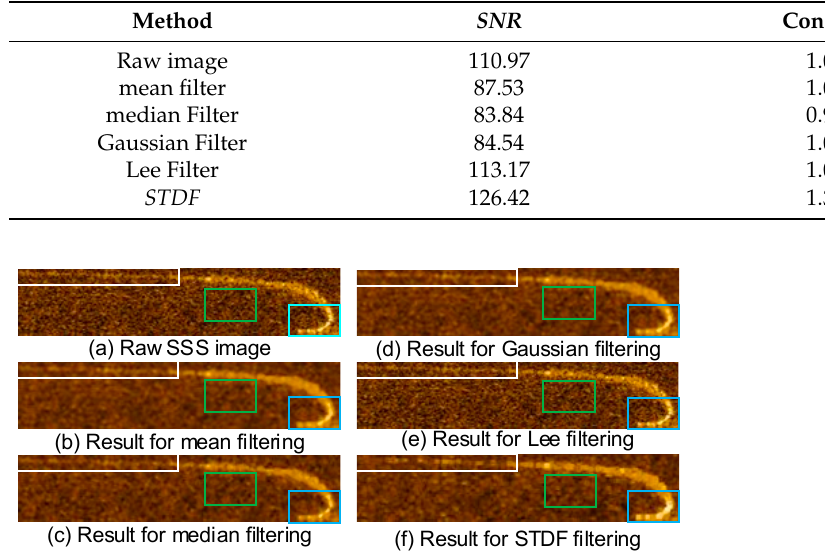
Figure 3. Results of the different filters. The subgraph ( a ) shows a raw SSS image without filtering, and subgraph ( b – f ), respectively, show the results for mean filtering, median filtering, Gaussian filtering, Lee filtering, and the STDF proposed in this paper.